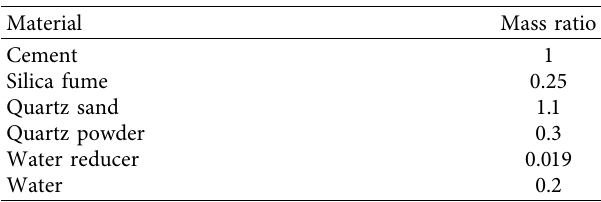
Figure 1: Details of the beams: (a) longitudinal configuration and (b) Section A-A and joints (units: mm). Table 1: Mix design of UHPC.